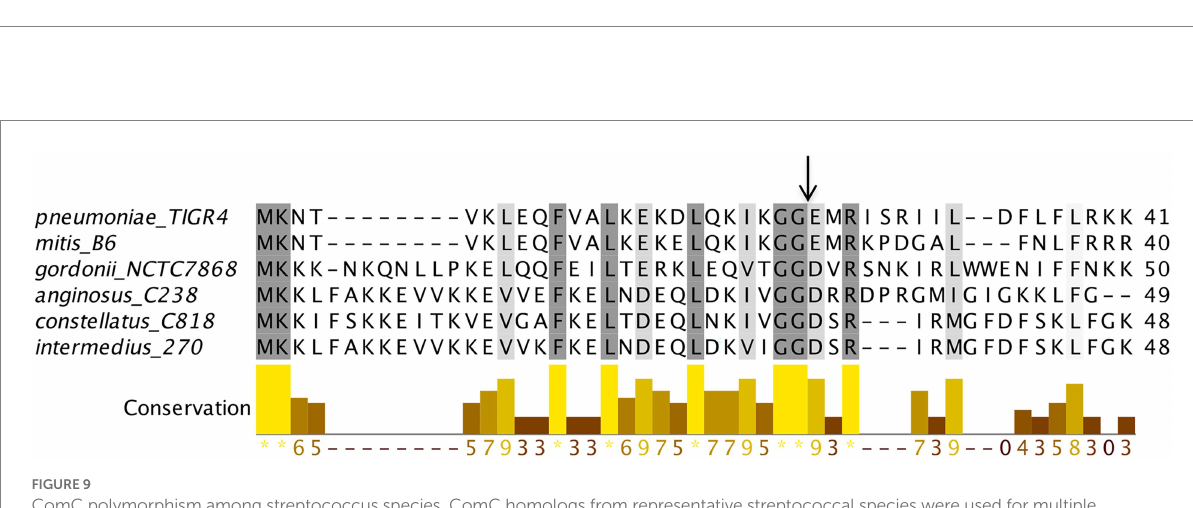
FIGURE 8 BlpC polymorphism from six streptococcus groups. (A) Multiple sequence alignment of BlpC homologs from six different streptococcal groups was performed using Muscle. The residues that showed ≥ 60% conservation were highlighted by grey color. Graph bar represents conservation in each column and arrow indicates the processing site to generate mature peptide. (B) Multiple sequence alignment of a variant of BlpC that is present in some streptococcal species.